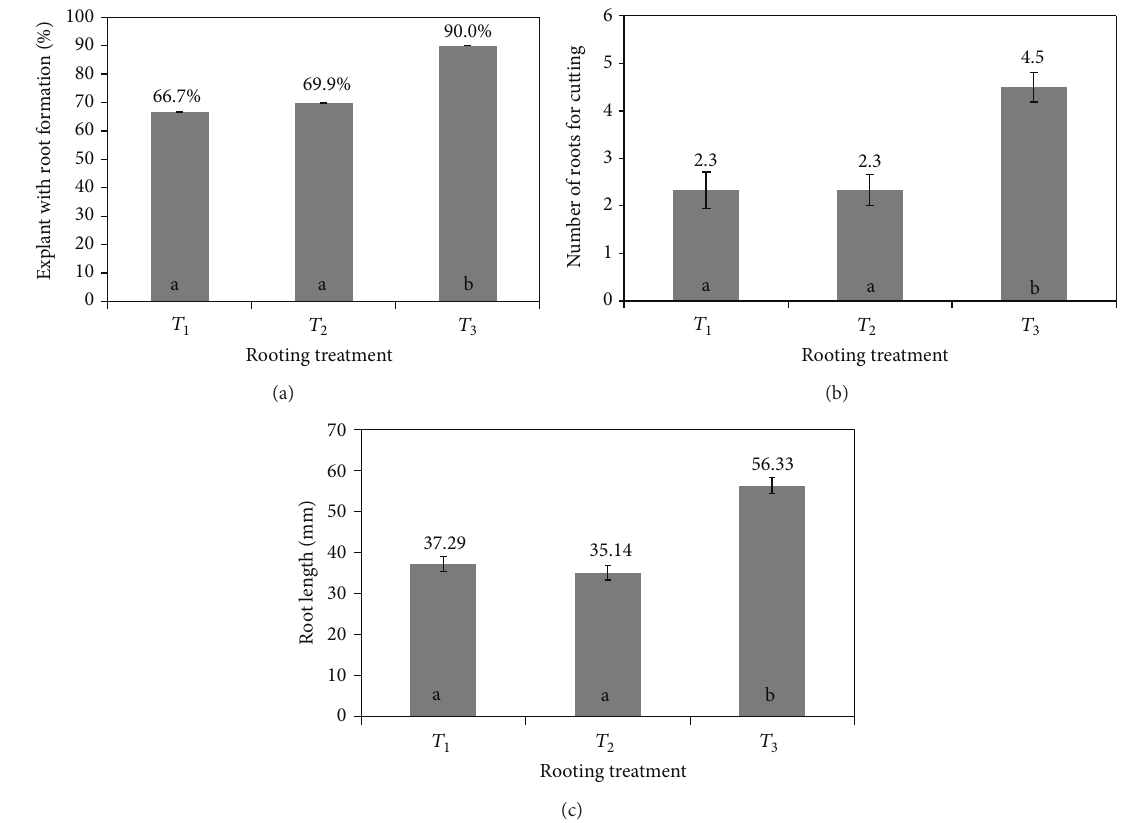
Figure 2: Adventitious rooting percentage (number of rooted cuttings/total cuttings in culture × 100) (a), number of roots for cutting (b), and root length (c) on Sc s of Olea europaea subsp. europaea var. sylvestris grown on different medium for 28 days. 𝑇 1 : OR medium without IBA; 𝑇 2 : short pretreatment with 14.7 mM IBA sterile solution and inoculation into the OR medium supplemented with 0.5 mg/L IBA; pretreatment with 14.7 mM IBA sterile solution and inoculation into the OR medium supplemented with 1mg/LIBA. The results represent the average value of two independent replicate. Means with common letters are not significantly different at 𝑃 ≤ 0.05 , according to Turkey’s Honestly Significant Difference (HSD) test.